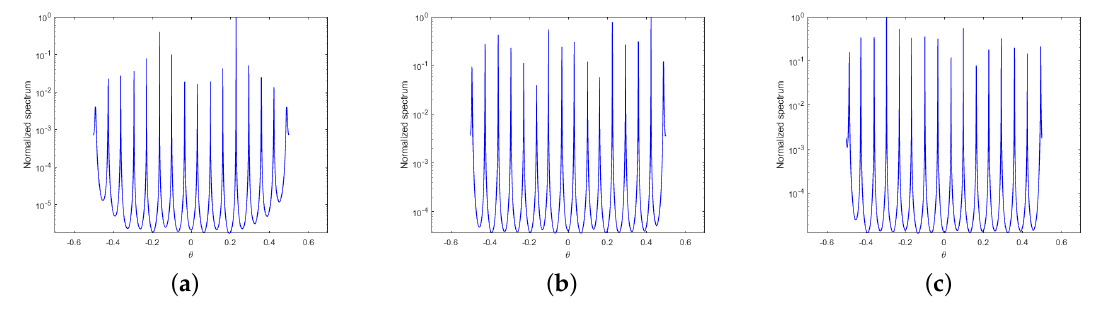
Figure 3. Spatial MUSIC spectrum ( a ) central ULA Based Approach; ( b ) hybrid Approach; ( c ) active coarray interpolation